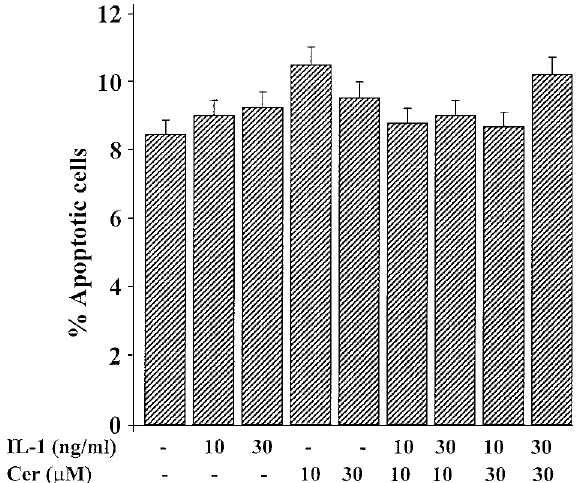
Table 2. Effect of interleukin-1 treatment on T-84 cells a